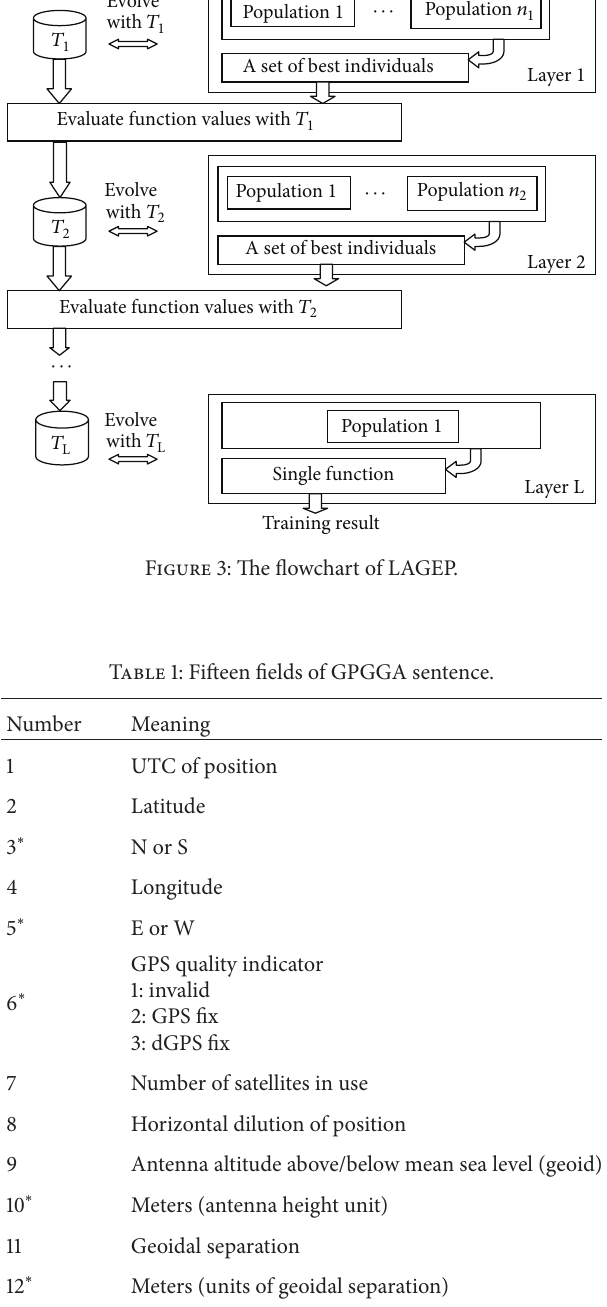
Table 2: Features of a training